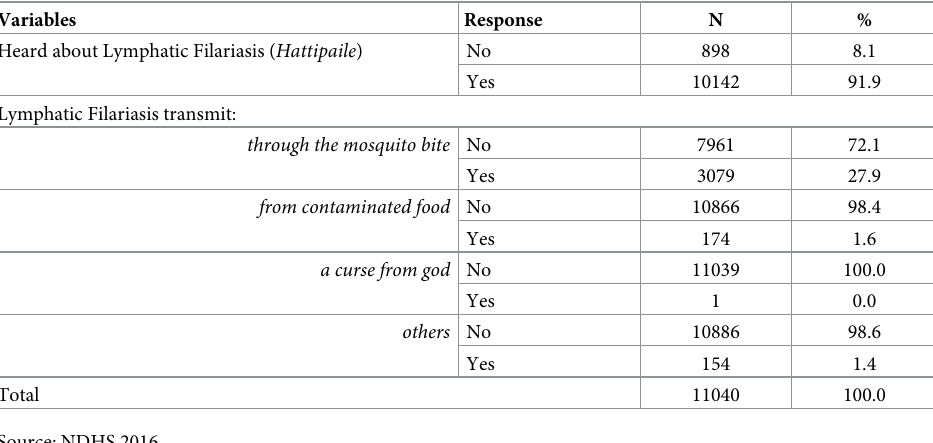
Table 2. Awareness of Lymphatic Filariasis ( Hattipaile ) and its mode of transmission. Variables Response Heard about Lymphatic Filariasis ( Hattipaile ) Lymphatic Filariasis